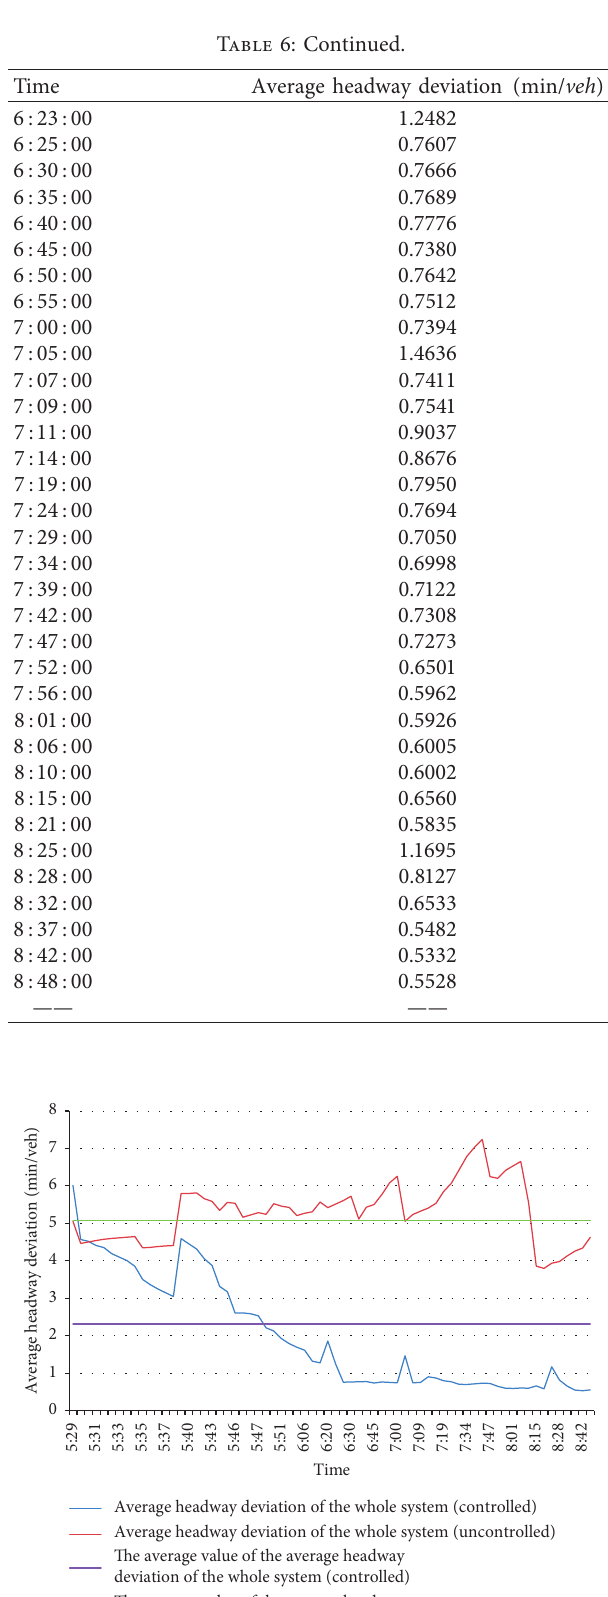
The average value of the average headway deviation of the whole system (controlled) The average value of the average headway deviation of the whole system (uncontrolled) Figure 9: Variation trend of average headway deviation of the whole system under controlled and uncontrolled